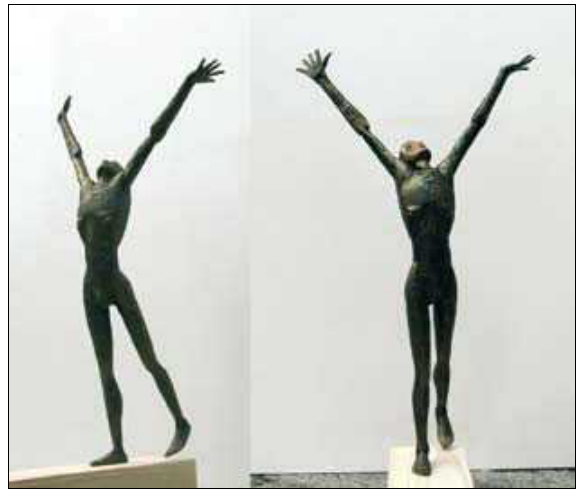
15 pav. Sim bo lio „Lais vė“ pa grin di nė kon cep ci ja – Lais vės troš ki mas Fig. 15. The main con cep tion of sym bol “Fre e dom“ is de si re for Fre e